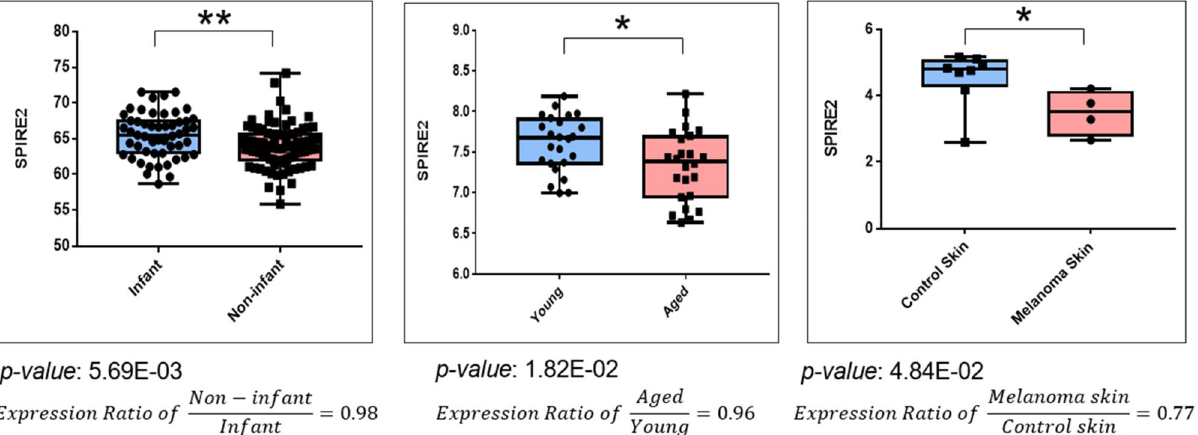
Figure 8. Gene expression of the pleiotropic and hub gene SPIRE2 is downregulated in non-infant skin, aged skin, and melanoma skin, when compared against expression levels in infant skin, young skin, and non- melanoma control skin respectively. Melanoma is a skin ageing phenotype. Expression ratio is the ratio of the average expression level in the cases (e.g., aged skin tissue) against the average expression level of the reference group (e.g., young skin tissue). Ratios above 1 indicate higher expression levels in the cases group while ratios below 1 indicate lower expression levels in the cases